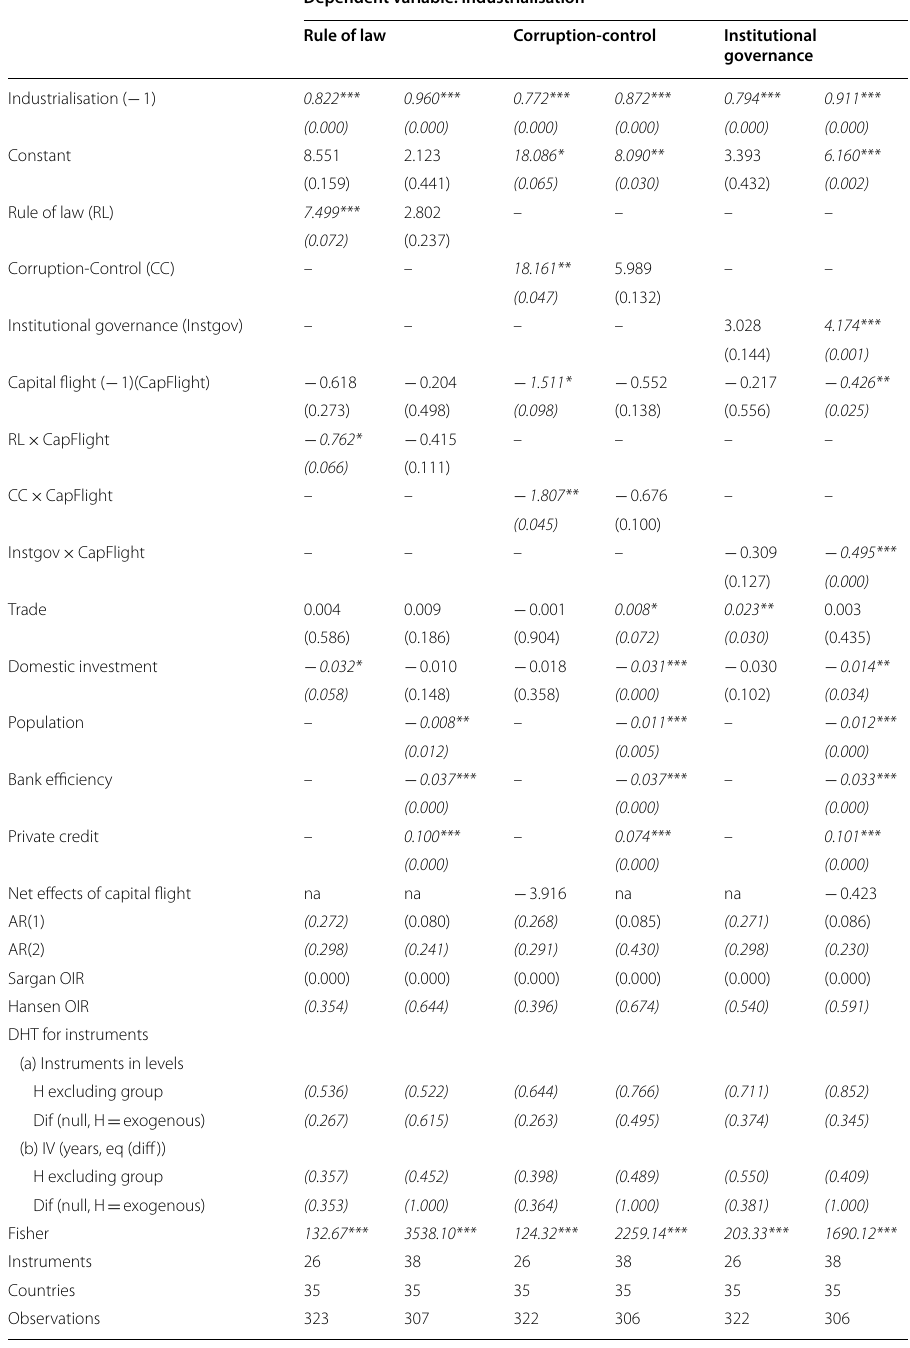
Table 4 Institutional governance, capital flight and